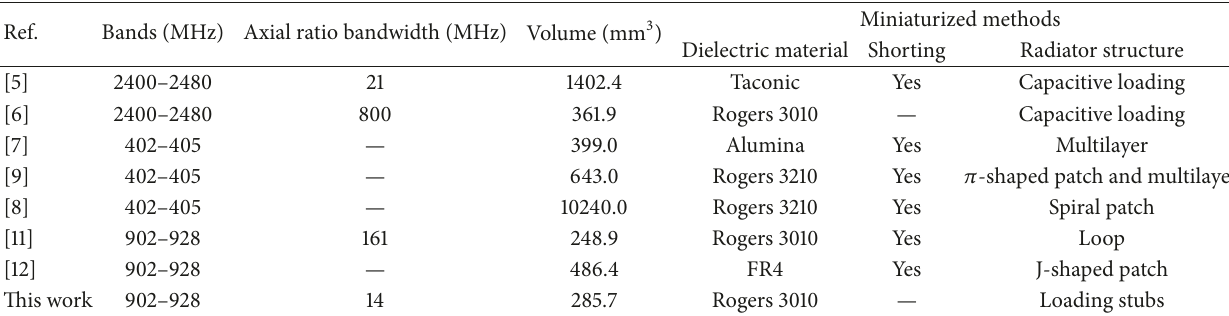
Table 3: Performance comparison of implantable